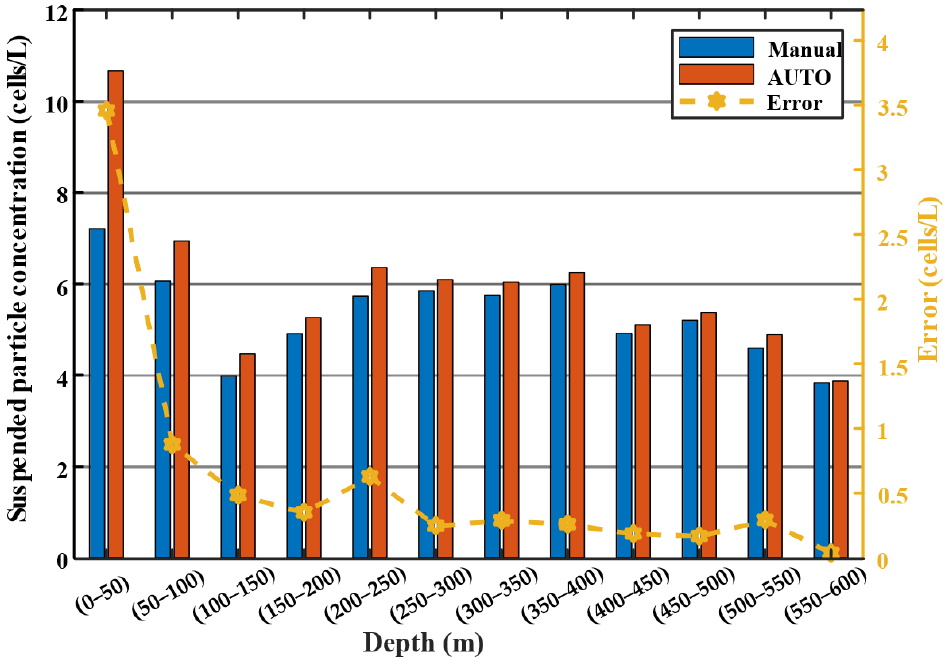
Figure 11. Estimated suspended particle concentration in the ocean by automatically (orange) and manually (blue) extracting the ROI in the holographic image.